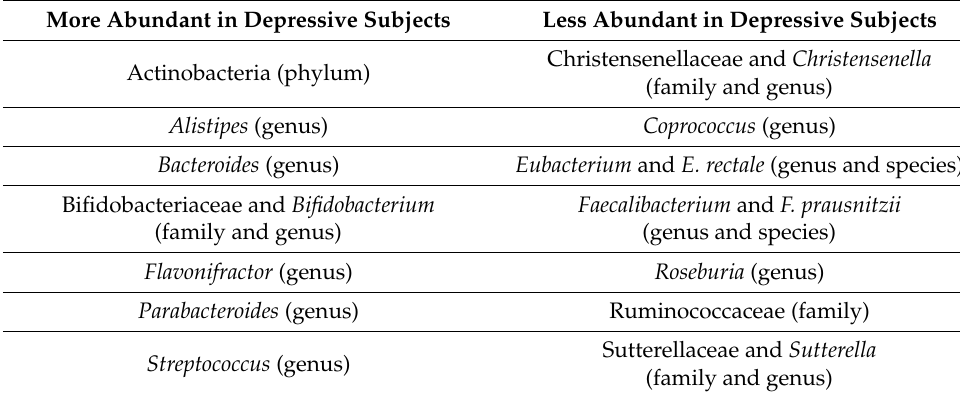
Table 8. Bacteria (with taxonomic level) that correlated most with